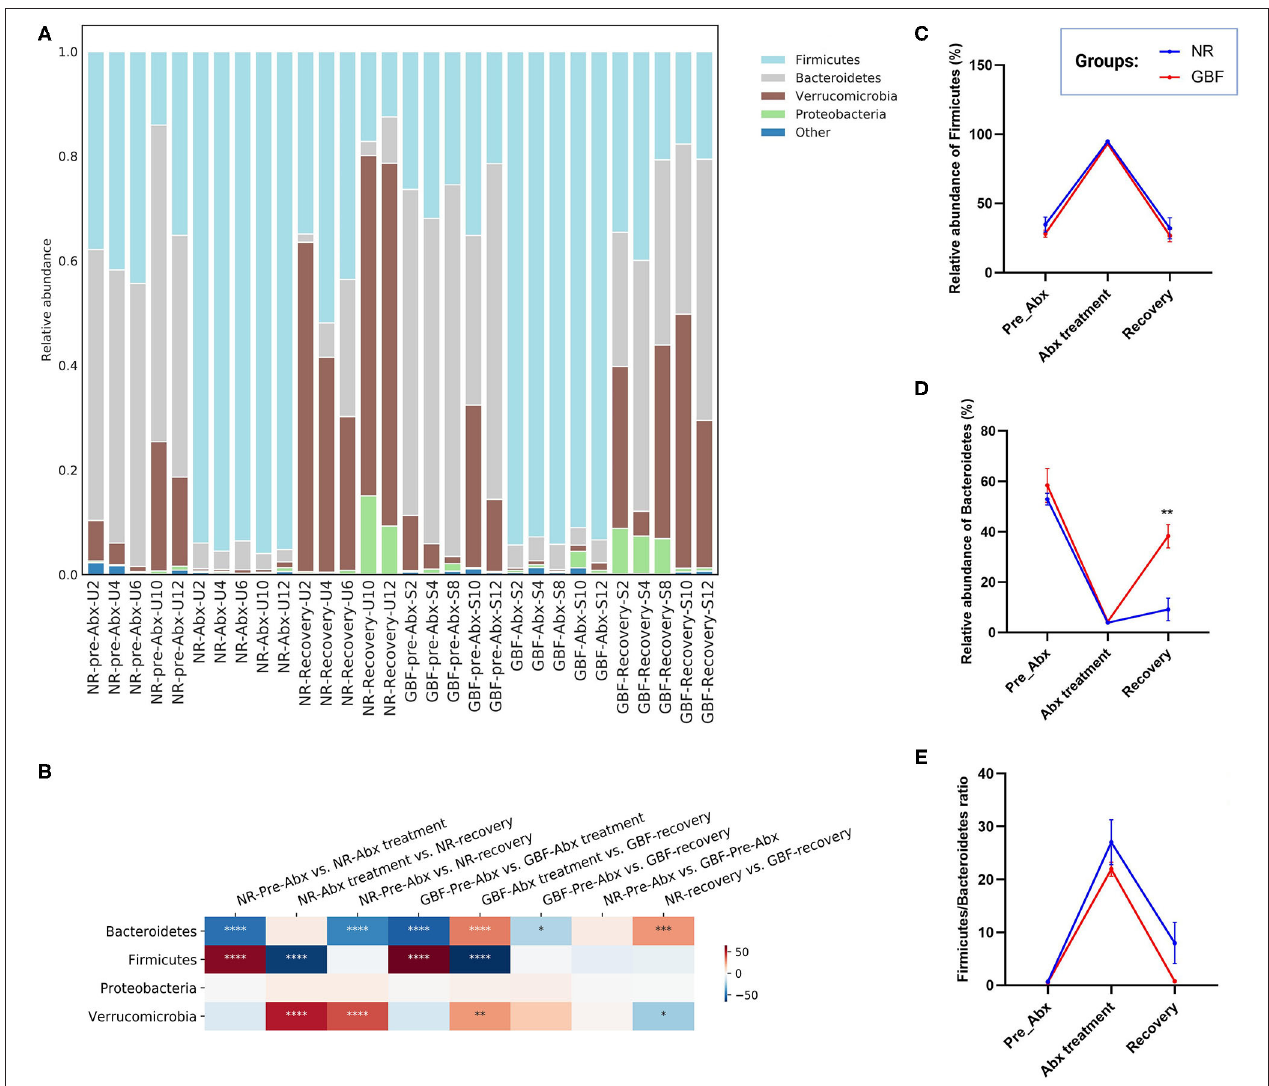
FIGURE 5 | Gut microbiota composition differences at the phylum level. (A) Microbiota composition differences. (B) Only the 4 more abundant phyla were represented and compared. Significance was determined using one-way analysis of variance corrected for multiple comparisons with the Tukey’s test, n = 5 per group. * P < 0.05, ** P < 0.01, *** P < 0.001, **** P < 0.0001. (C–E) The relative abundance of Firmicute, Bacteroidetes , and the Firmicutes / Bacteroidetes ratio from both groups were compared throughout the experiment. Significance was determined using two-tailed unpaired t -tests. The values are expressed as the means ± SEM, n = 5 per group. ** P <